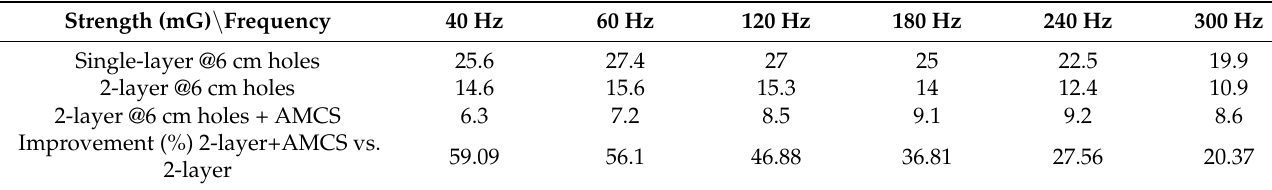
Figure 13. The magnetic strength of MFCS and PMCS. Table 12. Comparison of shielding capability of the PMCS and MFCS.